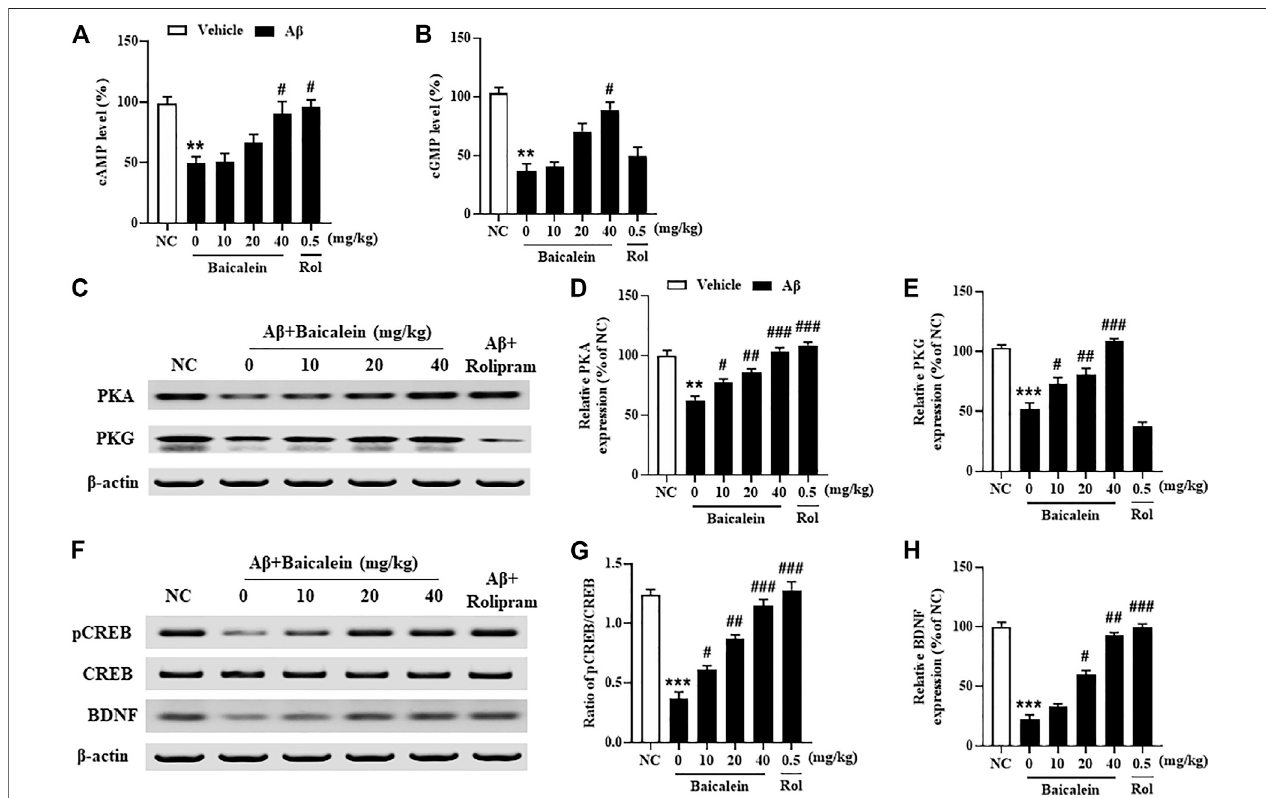
FIGURE8| Baicaleinincreased cAMP- and cGMP-downstreamproteins expression inthehippocampus ofA β -treated mice. (A,B) Thelevels ofcAMP/cGMP and (C – E) PKA and PKG, (F,G) the ratio of pCREB/CREB, and (H) the expression of BDNF were increased by baicalein treatment in A β -treated mice. All values were expressed as mean ± SEM ( n (cid:2) 6). ** p < 0.01, *** p < 0.001 vs. NC mice; # p < 0.05, ## p < 0.01, ### p < 0.001 vs. A β -treated mice.